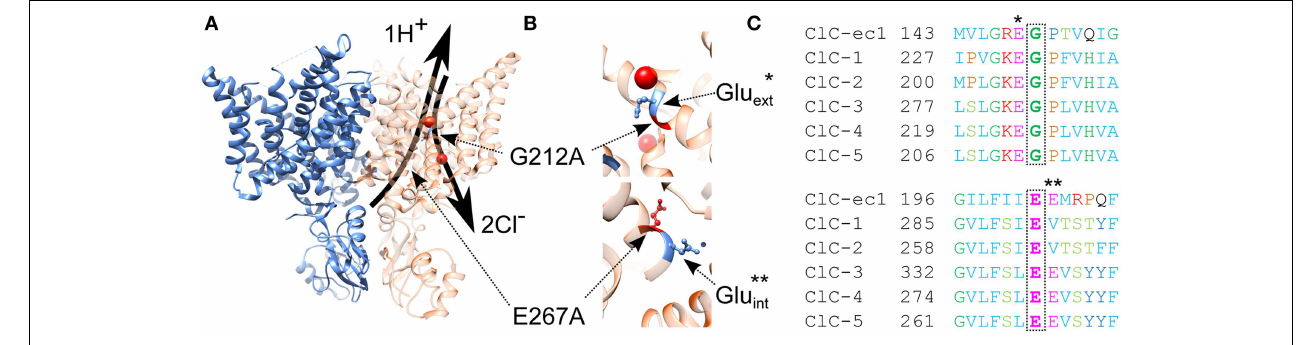
FIGURE 1 | Structural localization and evolutionary conservation of two Dent’s disease associated mutations. (A) Ribbon representation of the dimeric biological assembly typical for proteins of the CLC family and based on the crystal structure of the eukaryotic CmCLC (PDB id: 3ORG). Two identical monomers capable of mediating coupled chloride/proton exchange are assembled to form a functional CLC dimer. Superimposed as arrows on the right monomer are the anion and proton transport pathways, separated at the bottom (intracellular) side and converging at the central anion biding site to follow the same exit/entry pathway toward the top of the protein. The two here investigated Dent’s disease mutations are localized at key positions along these pathways—mutation G212A is located at the top of the protein at the